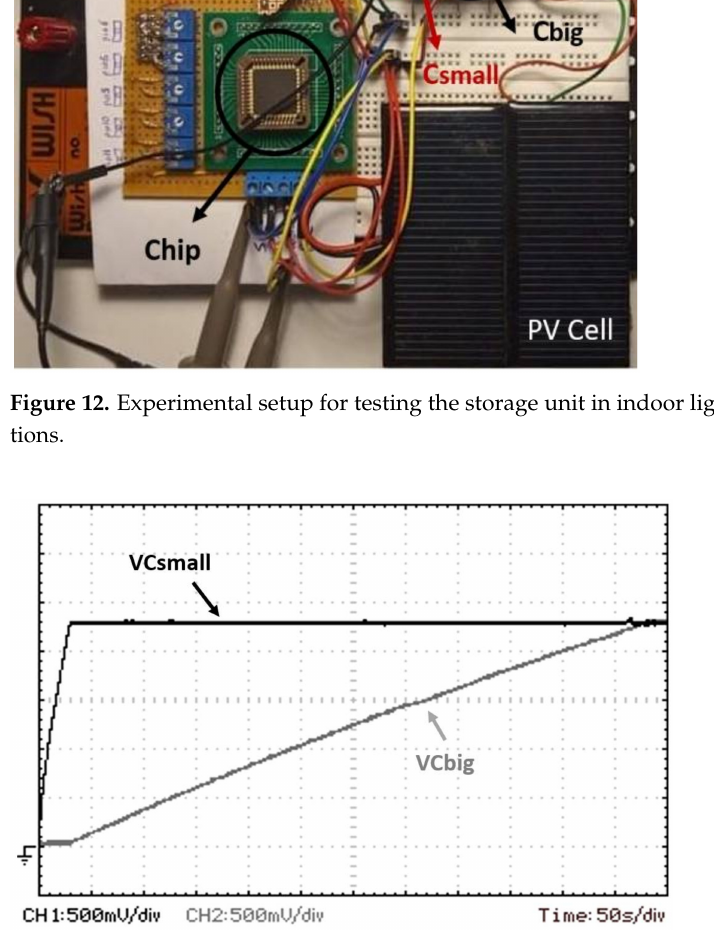
Figure 13. SCsmall (CH1) and SCbig (CH2) charging via